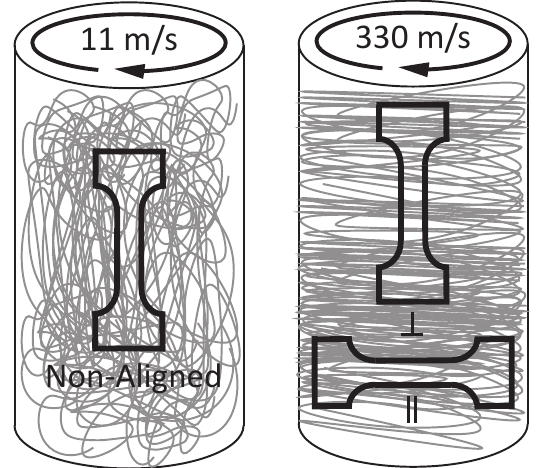
Figure 4. Schematics of dog-bone-shaped electrospun fiber mats illustrating the fiber alignment. Dog bones with randomly deposited fibers (11m/min), with fibers aligned along ( (cid:107) , 330m/min) and perpendicular ( ⊥ , 330 m/min) to the dog-bone axis (strain direction in tensile test experiments). Note that the latter two were cut from identical mats along and perpendicular to the rotational direction of the collector.